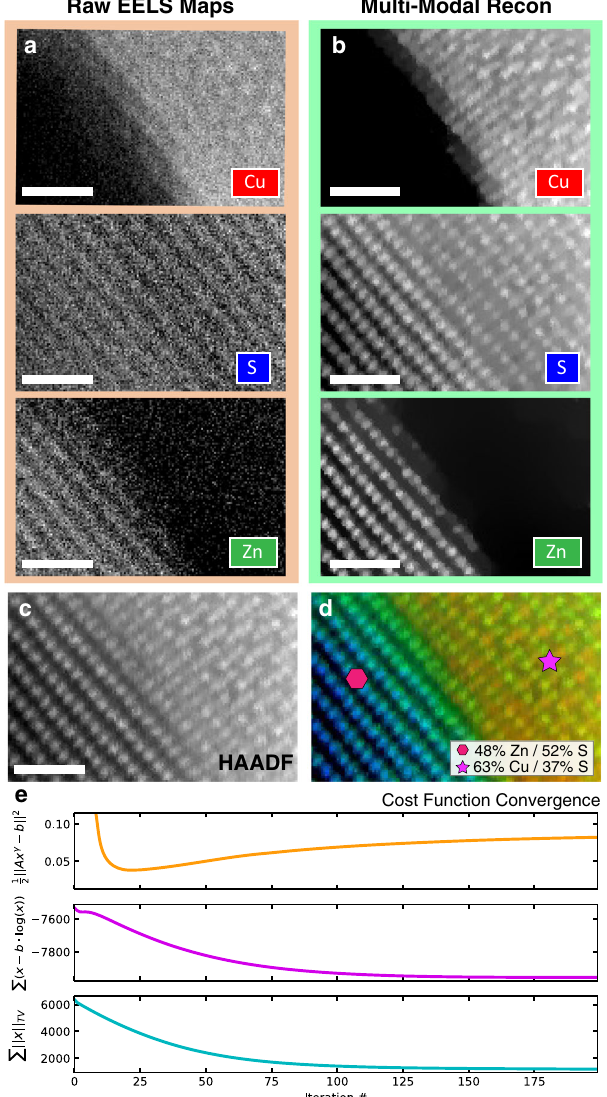
Fig. 3 Recovering chemistry in an atomically sharp ZnS- Cu 0.64 S 0.36 heterointerface interface. a The raw EELS maps for the Cu, S, and Zn L 2,3 edges. b The multi-modal reconstructions for the elemental compositions. c The simultaneous HAADF micrograph of the ZnS – Cu 0.64 S 0.34 interface. d Color overlay of the Zn, S, and Zn maps. The relative concentration for the constituent elements consists of 48 ± 5.9% for Zn, 59.9 ± 3.2% for Cu and 38 ± 2.6% for S in the Cu 0.64 S 0.36 layer and 48.9 ± 6% in ZnS. e Convergence plots for the three individual components in the cost function. Scale bar, 1 nm.